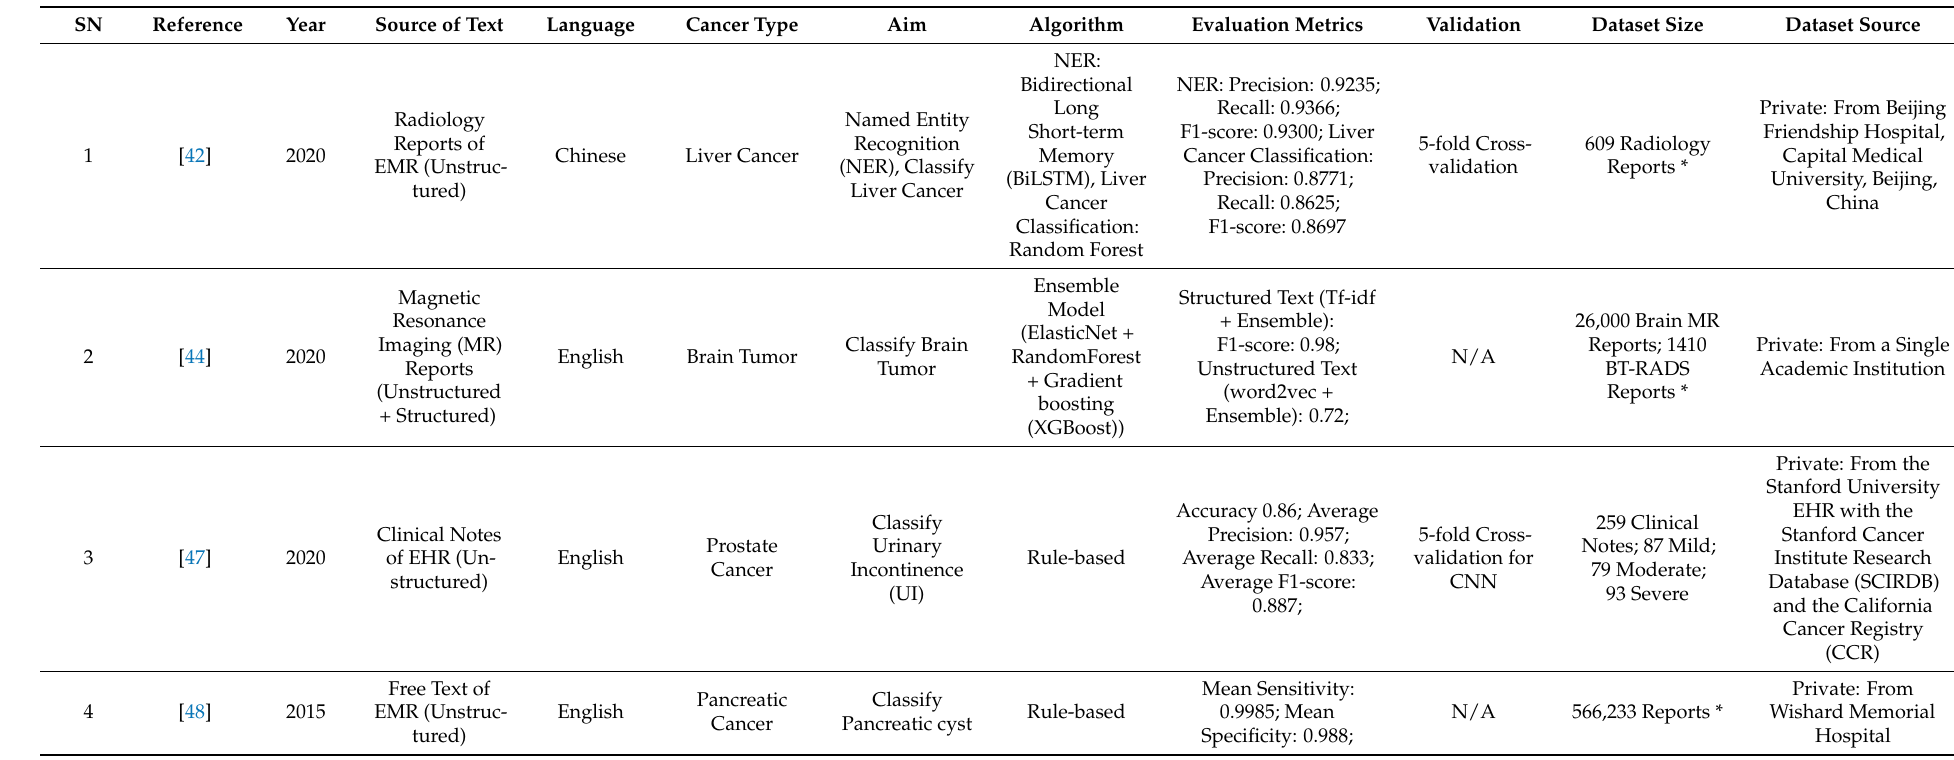
Table 6. Liver cancer, brain tumor, pancreatic cancer, and prostate cancer-related studies. * represents that we only show the size of the dataset because the dataset has too many types of data (more than three), the distribution of the dataset is not fully described, or it is not easy to show the structure of the dataset for other